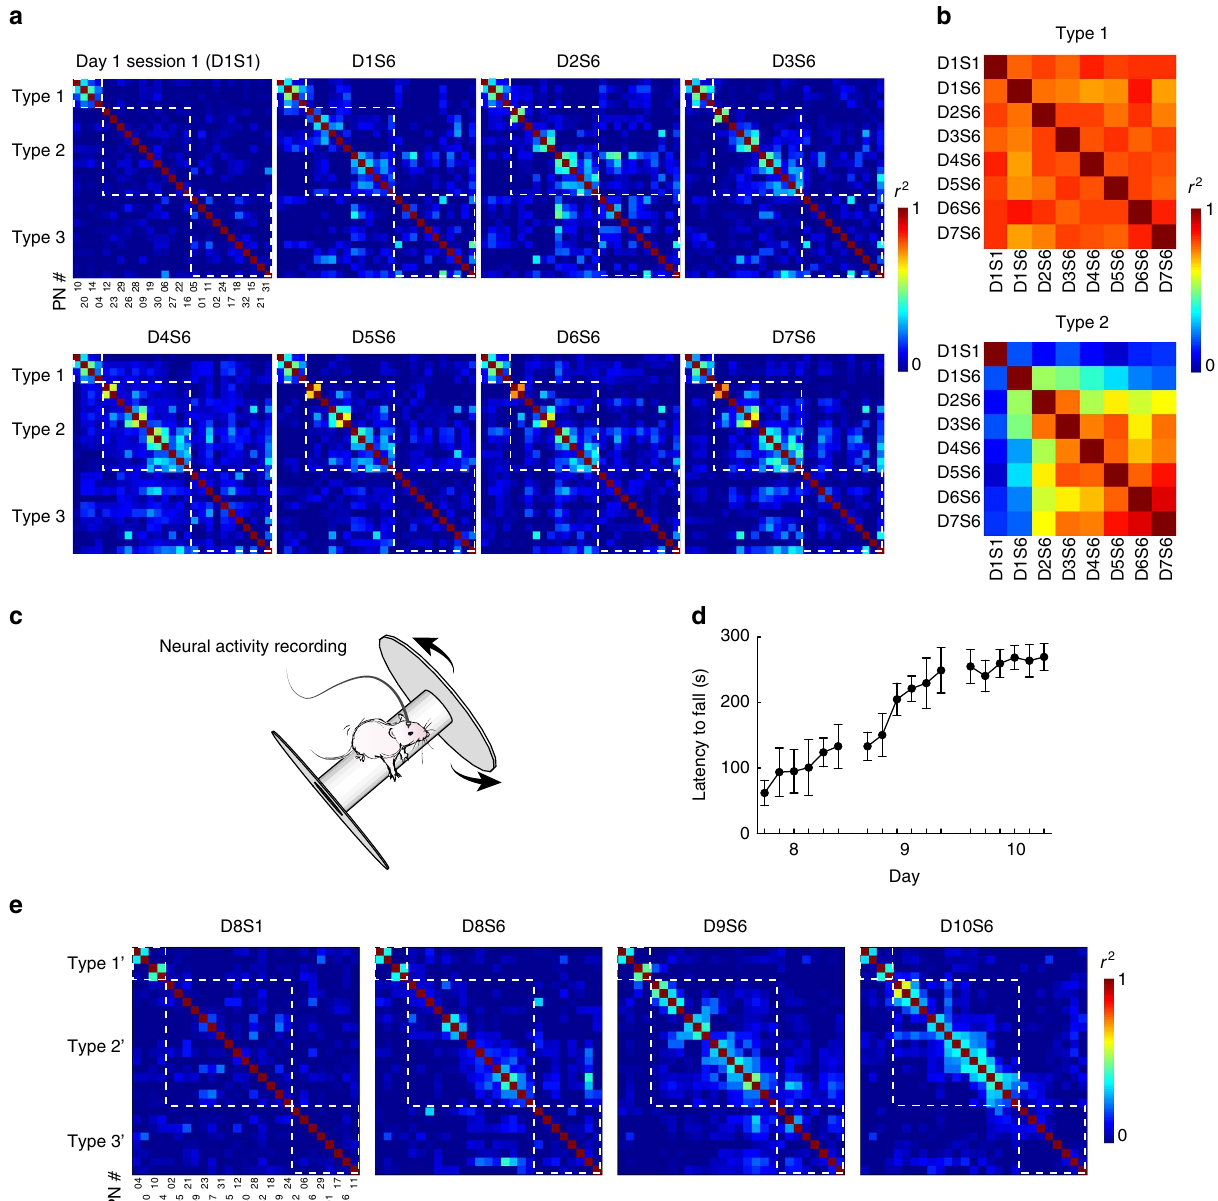
Figure 5 | Emergence of correlation structure of L5b PNs during motor learning. ( a ) Pairwise cross-correlation matrix of 27 L5b PNs across 7 training days, recorded from one representative rat during first reach success attempts (controlled for trajectory variance, see Methods). Neurons are ordered (PN #) according to the sequence of hierarchical clustering shown in Supplementary Fig. 5b. The squares from top to bottom segregate type 1 to type 3 L5b PNs identified. Increased correlation is evident only among the groups of neurons that show increased I M and decrease of t opt. , that is, type 2 neurons. ( b ) Summary of the preserved overall similarity of cross-day correlation matrix among type1 and type 2 PNs. Each colour-coded element represented the averaged similarity index of cross-day correlation matrices from five rats. ( c ) Paradigm of rotarod running. Rats were trained to run on the rotarod accelerating from 4 to 40 revolutions per minute over 300s. Each trial ended when the rat fell off or when 300s was reached. Each animal received six training sessions every day, and each lasted 10min with 5-min rest intervals. ( d ) Latency to fall off the rotarod during training. Animals showed fast improvement in performance on the first two days and maintained throughout the third day (mean ± s.e.m. of latency to fall in day 1 session 1: 62.0 ± 19.1s, day 1 session 6: 133.0 ± 33.4s, P ¼ 0.051; day 2 session 1: 132.1 ± 21.7s, day 2 session 6: 249.0 ± 34.6s, P ¼ 0.007; day 3 session 1: 255.2 ± 25.7s, day 3 session 6: 269.5 ± 20.3s, P ¼ 0.681, all compared to day 1 session 1, one-way repeated measures ANONA, 4 rats). ( e ) Pairwise cross-correlation matrix among the 27 L5b PNs shown in a , but re-ordered for clustering with high correlation coefficient near the diagonal during 3 days’ rotarod training (day 8 to day